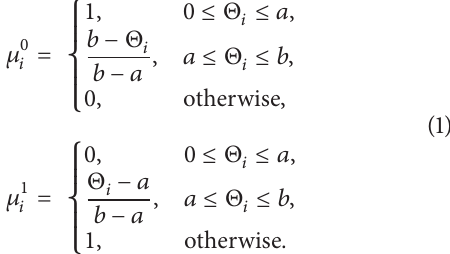
Figure 1: Structure of the diagnostic